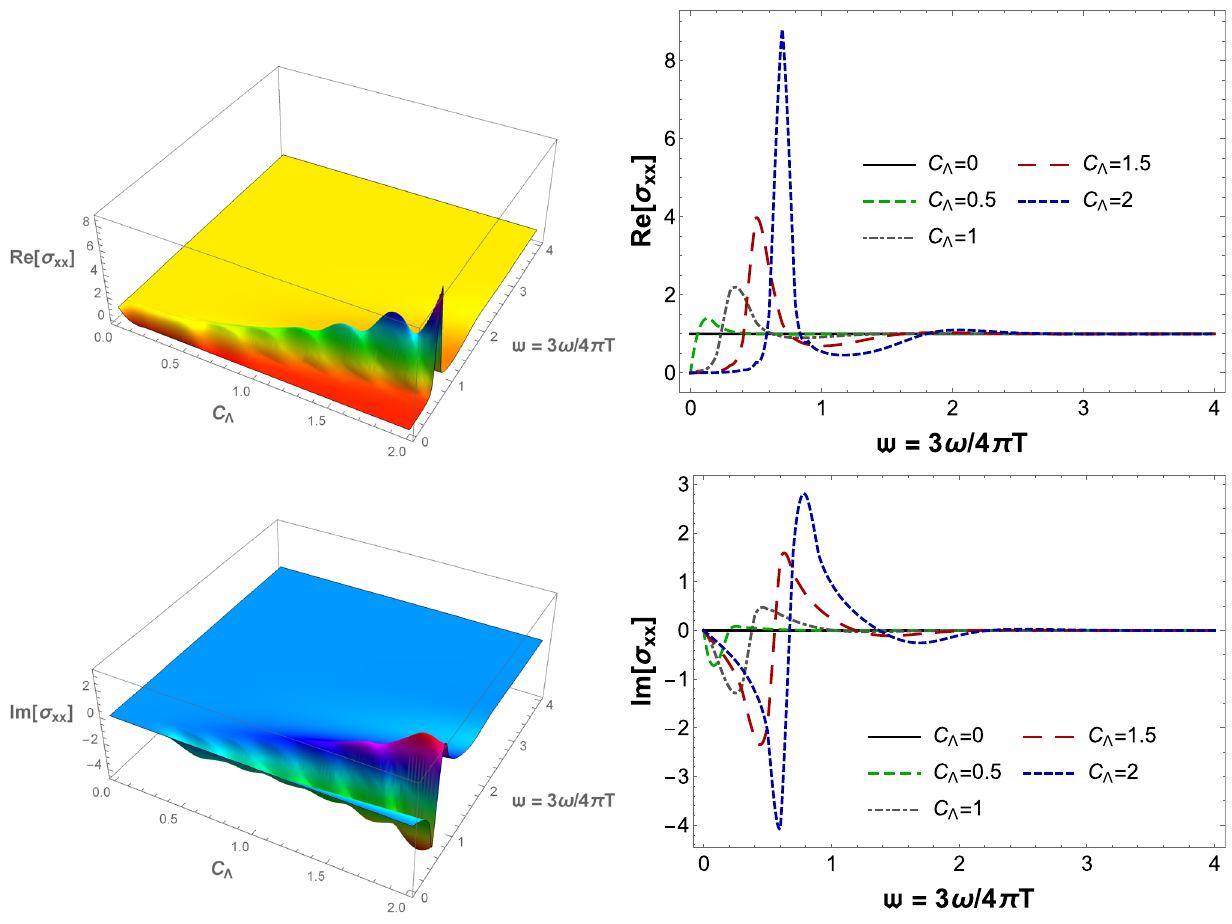
Fig. 11 Real and imaginary parts of the diagonal AC conductivity as functions of ( C (cid:12) = (cid:12) L / 2 , w = 3 ω/ 4 π T ) at fixed θ = 1. These results were generated with the mass function M ( u ) = tanh ( u 2